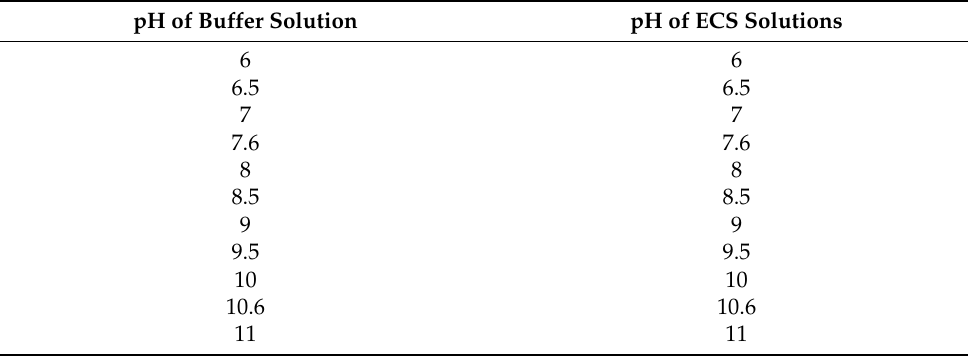
Table 2. Effect of ECS additives on the pH values of buffer